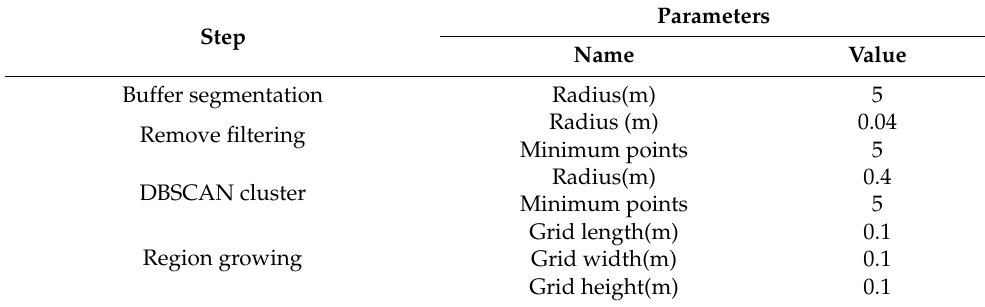
Table 4. Pole extracting